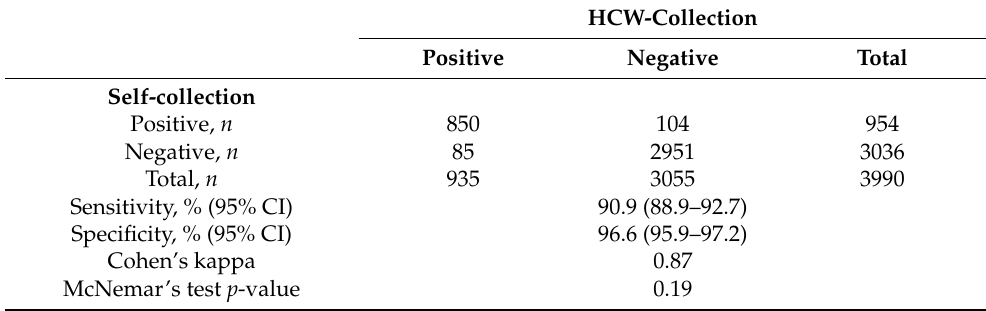
Table 2. Comparison of clinical diagnosis performance between self-collection and